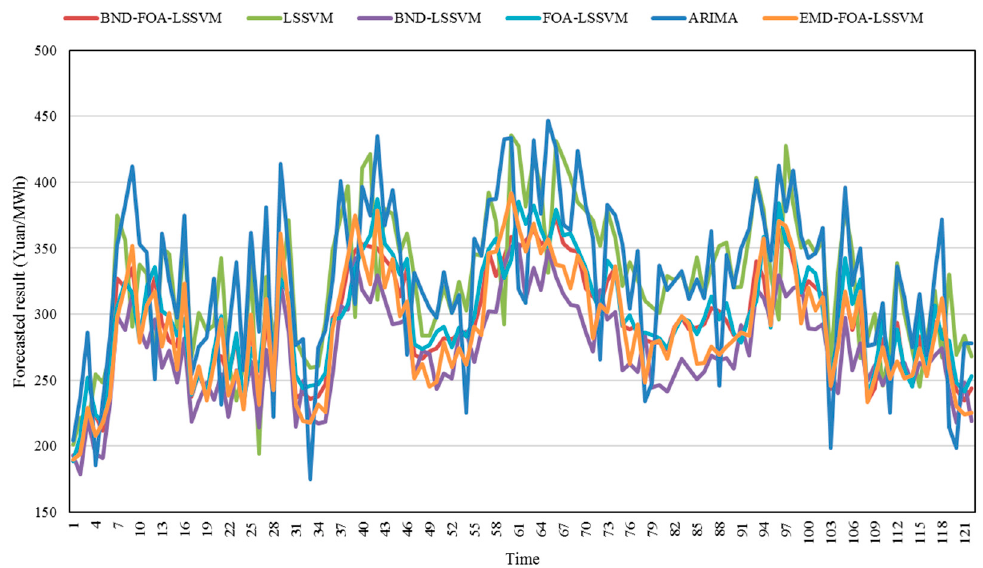
Figure 6. Forecasting results of electricity price from 1 September and 31 December by using different methods.